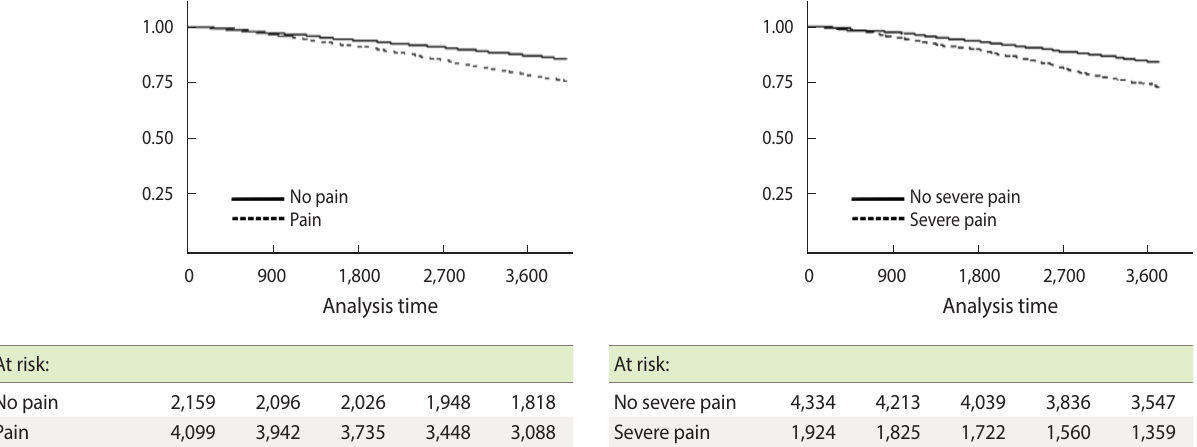
Figure 1. Kaplan–Meier estimate for survival rate according to pain phenotype in 2006-2016. The y-axis represents the survival rate and the x-axis represents the period of survival (in days). The numbers on the bottom are number of survivors for each group at the time of analysis.